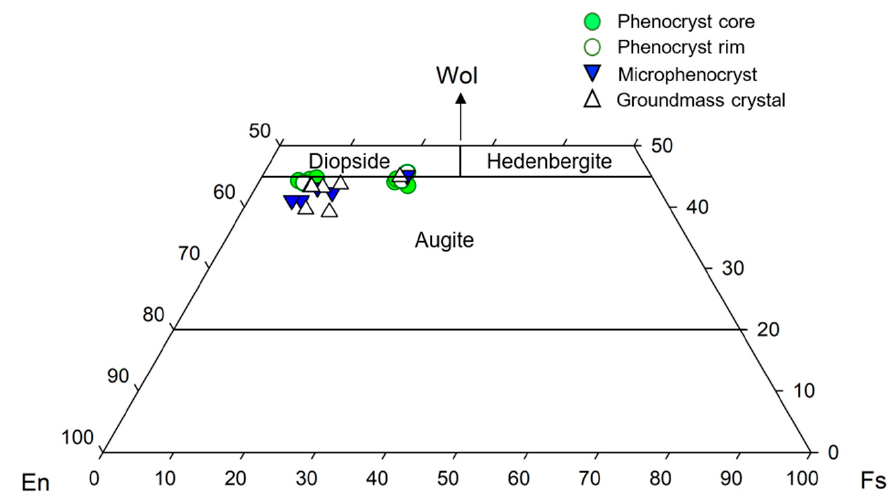
Figure 3. Classification diagram of pyroxene [31] from the Laghetto rocks.